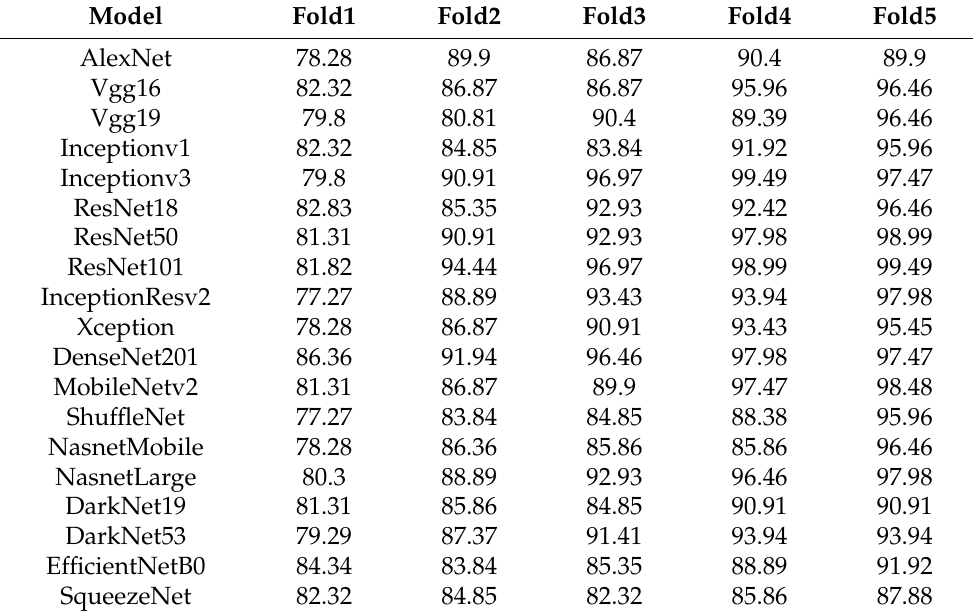
Table 3. The obtained accuracies over five folds in the 19 CNN